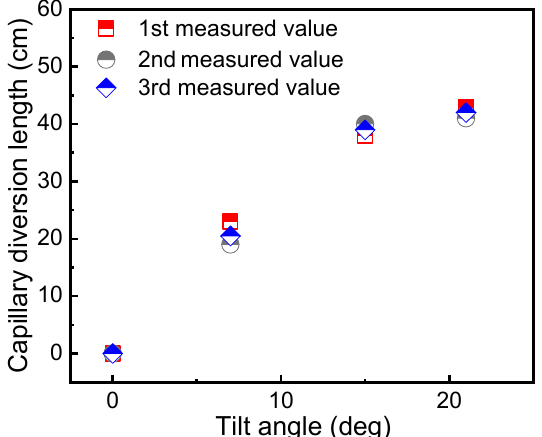
Figure 13. Effect of the tile angle on the capillary barrier diversion length in a multi-layer slope in case I, II, III, and IV (each case was performed three times for the same experimental conditions).